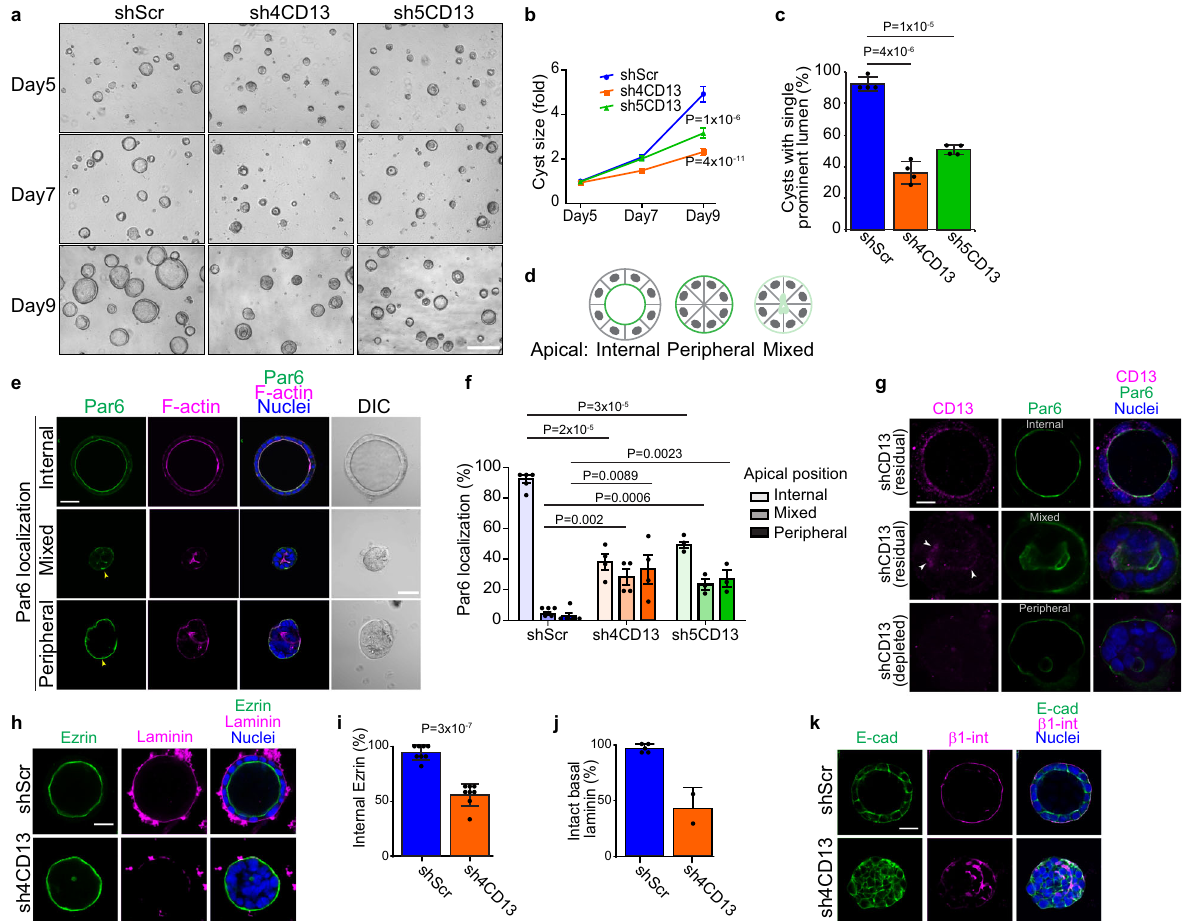
Fig. 2 CD13 knockdown disrupts the orientation of apical-basal polarity. a Phase contrast images showing the phenotype of shScr, sh4- and sh5-CD13 knock-down in 3D Caco-2 cysts after 5, 7, and 9 days in culture. b Quanti fi cation of the size of 3D Caco-2 structures for the indicated conditions after 5, 7, and 9 days in culture. Data are reported as mean ± SEM for the indicated conditions ( n = 129 shScr, n = 126 sh4-CD13, and n = 160 sh5-CD13 cysts) from a single representative experiment. Comparisons of multiple means were performed by ANOVA using Tukey ’ s post-hoc test on data from day 9. c Quanti fi cation of cysts with single prominent lumen of shScr ( n = 806), sh4-CD13 ( n = 961) and sh5-CD13 ( n = 1312) knock-down in 3D Caco-2 cysts on day 10. Individual dots represent mean values from each of 4 independent experiments. d The schematic diagram showing different phenotypes (internal, peripheral, mixed) of apical Par6 observed. e Confocal images of Par6 (green) and F-actin (magenta) showing different Par6 localization (internal, peripheral, mixed) in 3D Caco-2 cysts. Yellow arrow heads indicate peripheral Par6 localization. f Quanti fi cation of Par6 localization (internal, peripheral, mixed) in Caco-2 structures for the indicated conditions ( n = 358 shScr, n = 336 sh4-CD13, and n = 187 sh5-CD13 cysts) after 10 days in culture. Dots represent the mean from each of 4 independent experiments. g Confocal images of shCD13-expressing Caco-2 cells immunostained for endogenous CD13 (magenta) and Par6 (green) to visualize residual/depleted CD13 in individual cysts with different phenotypes. h Confocal images CD13 knock-down Caco-2 cysts immunostained for Ezrin (green) and laminin (magenta) showing cells with inverted apical-basal polarity. i Quanti fi cation of internal Ezrin in shScr ( n = 168) and sh4CD13 ( n = 150) 3D Caco-2 cysts after 10 days in culture. Dots represent means from each of 8 independent experiments. j Quanti fi cation of intact basal laminin in shScr ( n = 71) and sh4CD13 ( n = 35) Caco-2 cysts after 10 days in culture. Dots represent means from each of two independent experiments. k Images for E-cad (green) and β 1-integrin (magenta) showing cell polarity are disrupted in CD13 knock-down 3D Caco-2 cysts. Data are represented as mean ± SEM ( b , f ) or mean ± SD ( c , i , j ). p -values were calculated by ANOVA with Tukey ’ s posthoc test for multiple comparisons ( b , c , f ) or unpaired two-tailed student ’ s t-test ( i ). Images are representative of two ( k ) three ( a ), or four ( e , g , h ) independent experiments. Bars: a , 200 μ m; e , 50 μ m; g , 20 μ m; h and k , 30 μ